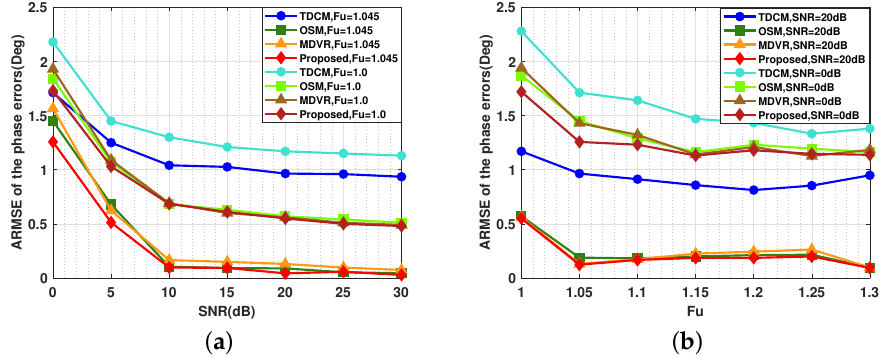
Figure 8. ARMSE of channel phase errors versus SNR and F u . ( a ) ARMSE of the channel phase errors versus SNR. ( b ) ARMSE of the channel phase errors versus F u